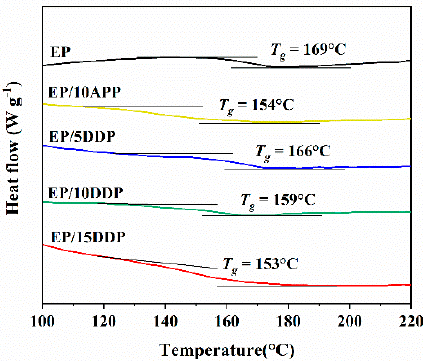
Figure 7. DSC curves of flame ‐ retarded EP blends at a heating rate of 10 °C/min in nitrogen.